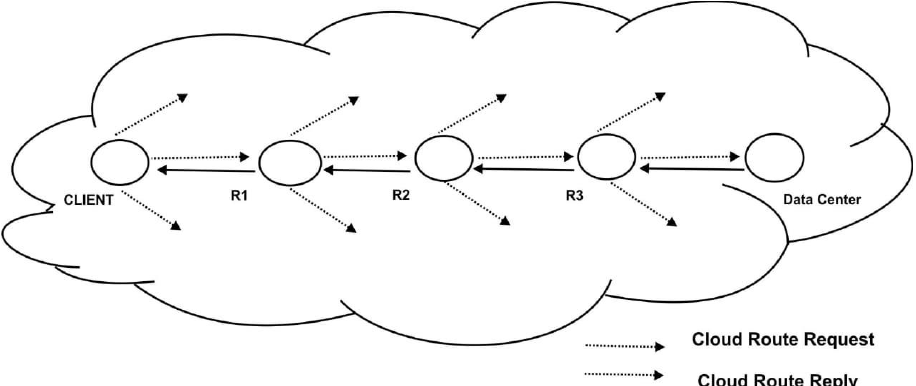
Figure 2. Broadcast of route request and returning of route